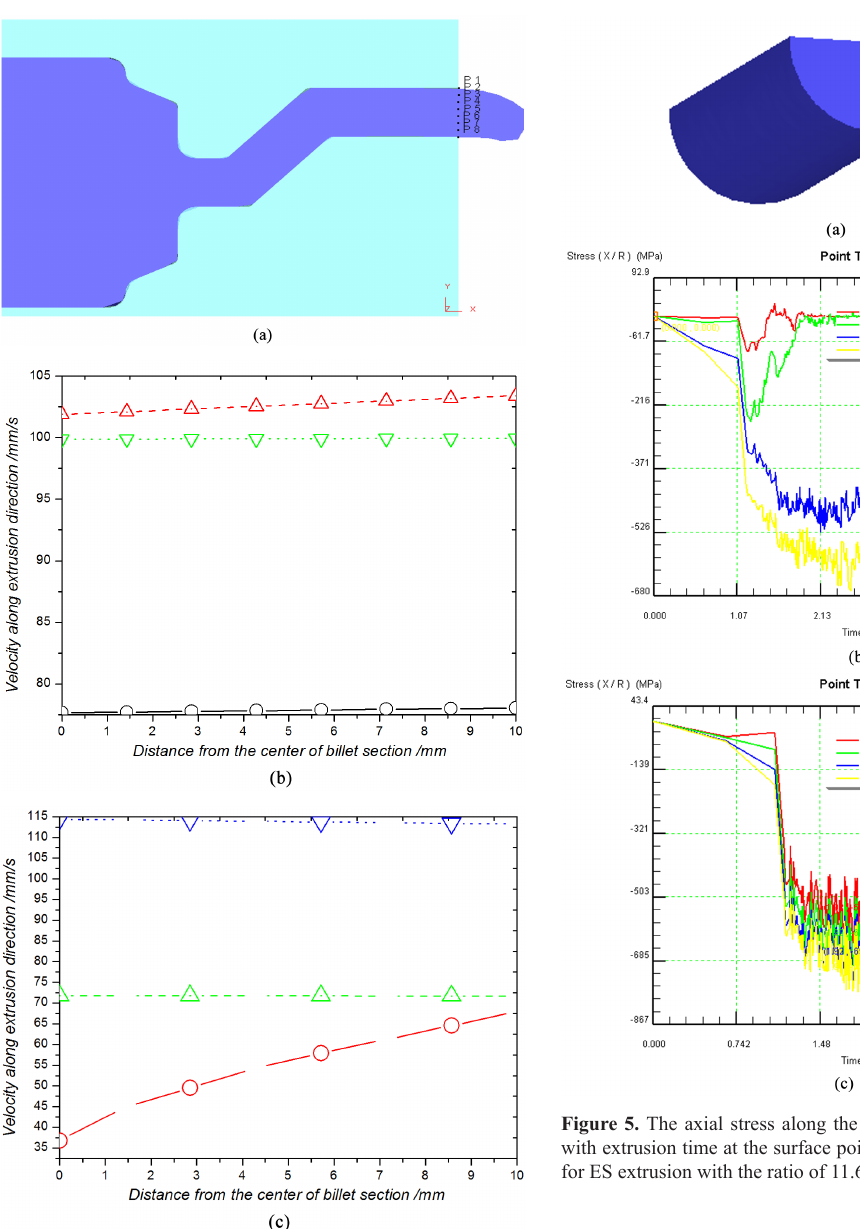
Figure 4. Flow velocities along extrusion direction at the die exit with different dies. angles: (a) the investigated points at the die exit, ES extrusion with ratio of 11.6 (b), and 28 (c).